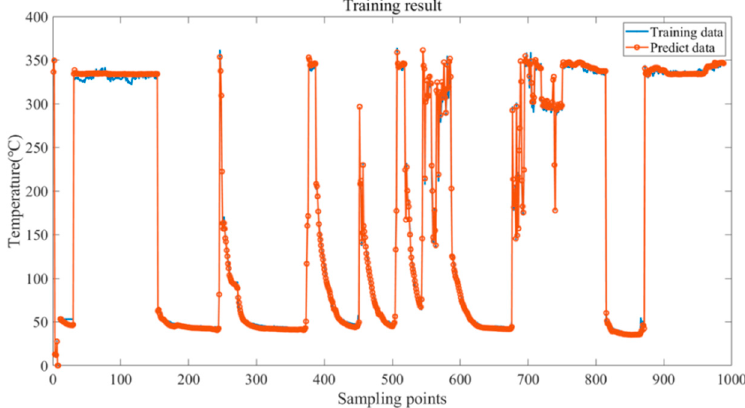
Figure 7. Model training result curve.